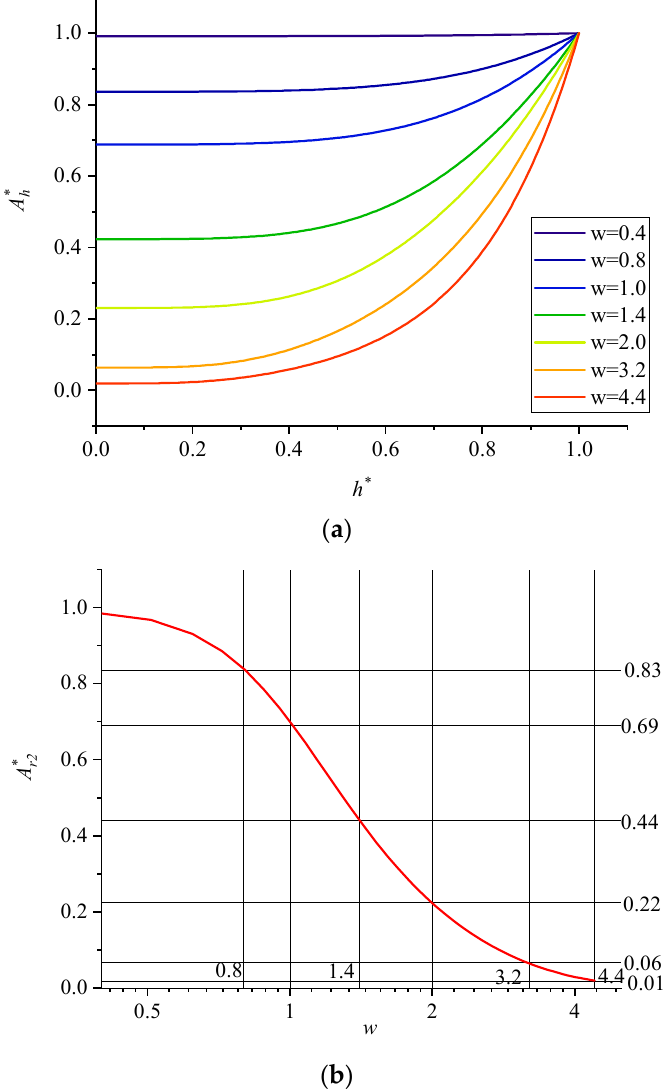
Figure 8. Dimensionless temperature fluctuation amplitude distribution at different relative wall thickness w ( a ) distribution along the dimensionless wall thickness h* ( b ) temperature distribution along the adiabatic surface r = r 2 .